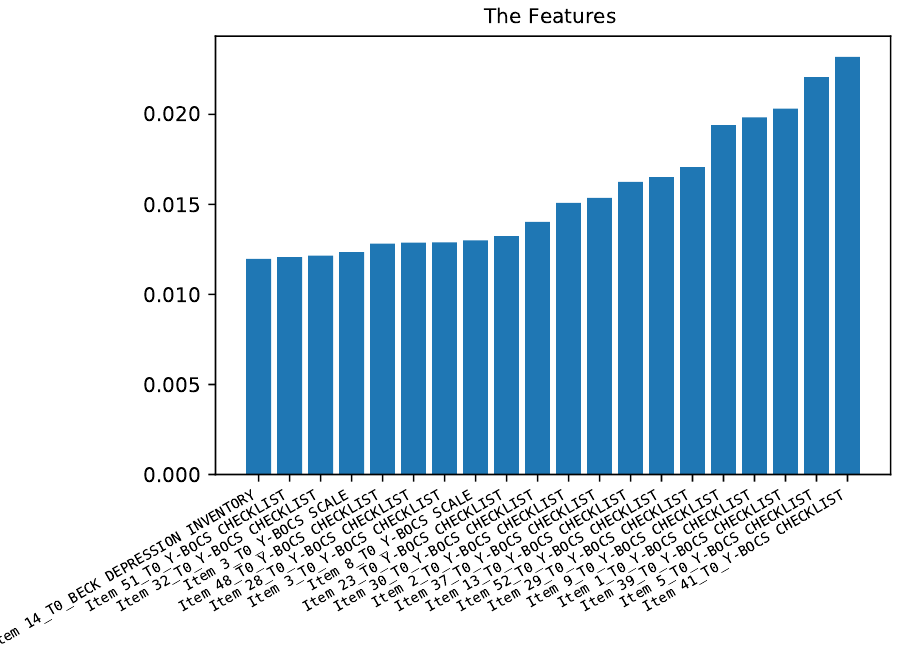
Figure 7. Importance of the different features for predicting obsessive and compulsive symptoms.